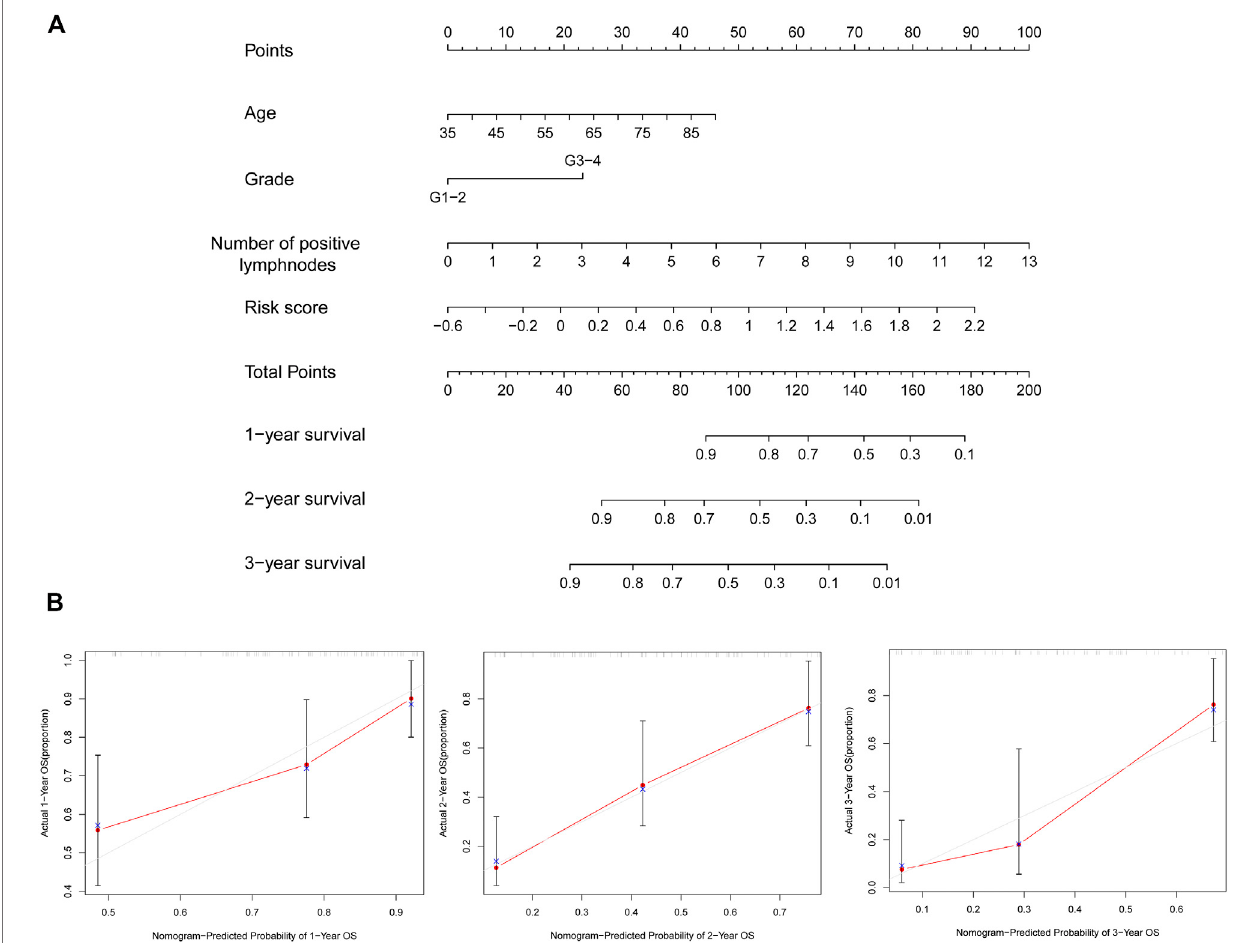
FIGURE 8 | Generation of the nomogram together with prognostic risk signature and clinical parameters. (A) Nomogram that combined the risk score and screenedclinicalparameterstopredicttheprobabilityof1-,2-,and3-yearOSofpatientswithPC. (B) Calibrationcurvesof1-,two-and3-yearOSwereusedtoevaluate the predictive performance of the nomogram. The 45 ° line represents the ideal best predictive model. The red line represents the actual model we constructed. OS, overall survival; PC, pancreatic cancer.